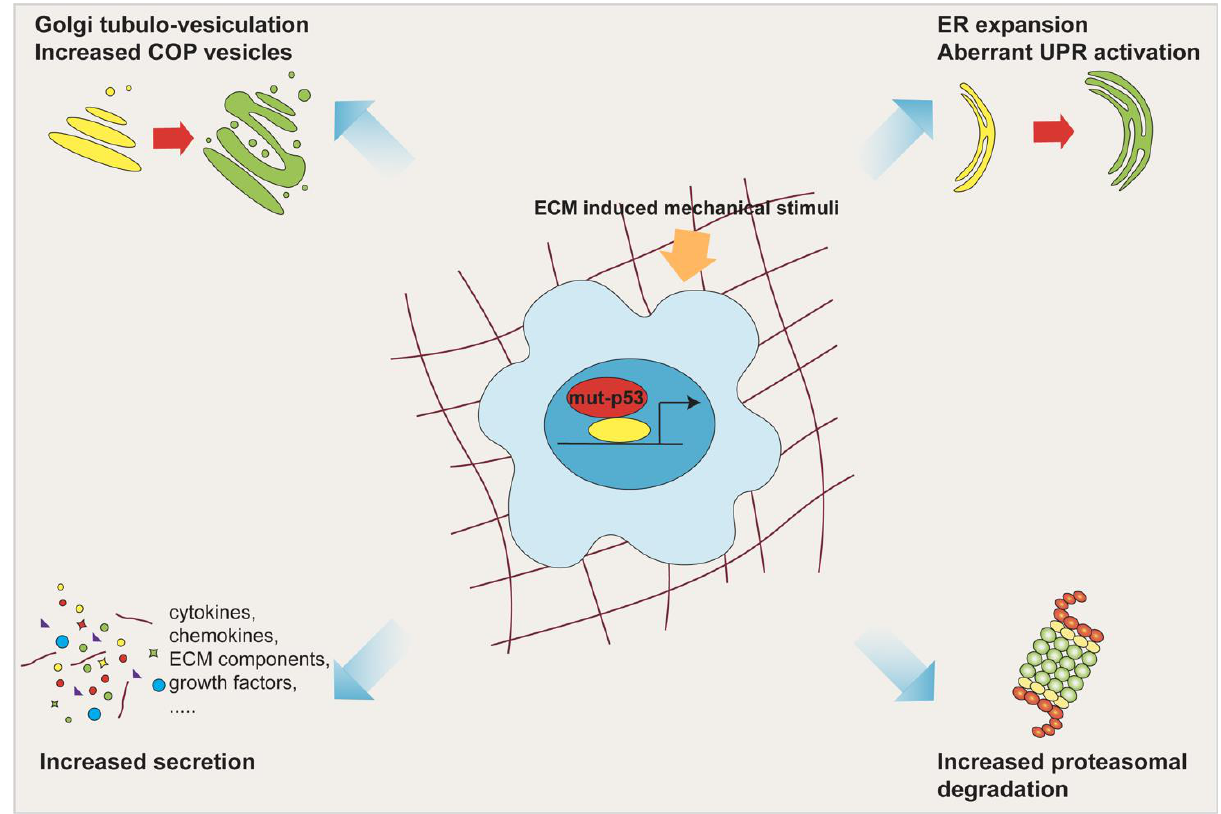
FIGURE 2: Mut-p53 modifies the cell secretory pathway. Mut-p53, via miR-30d, induces major structural alterations of the secretory path- way components, including ER enlargement, increase in number of COP vesicles, and tubulo-vesiculation of the Golgi apparatus. These morphologic alterations, together with overwhelming of ER folding capacity and enhancement of proteasomal protein degradation, cause functional modification of the whole secretory pathway, culminating in increased trafficking rate. All these features are fostered by me- chanical stimulation deriving from the